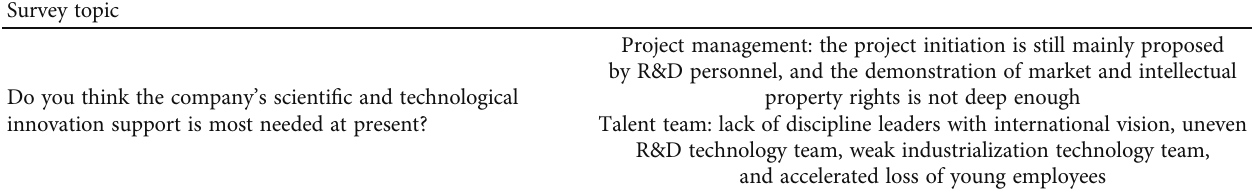
Table 10: Open question 2 question